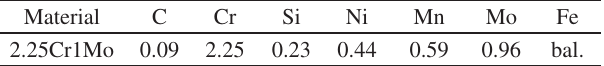
Table 1. Nominal chemical composition (in wt. (%)) of the 2.25Cr1Mo low-alloy steel. Material